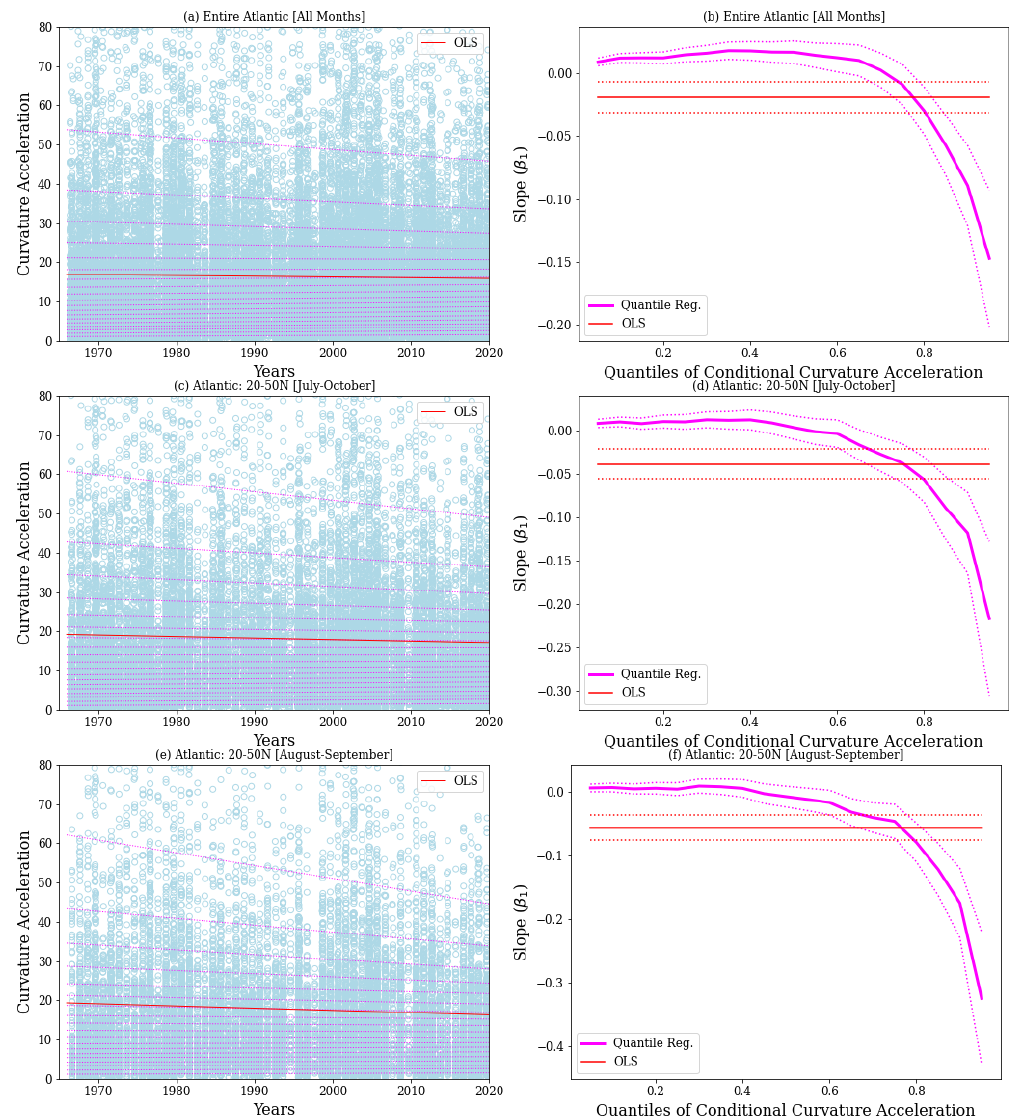
Figure 14. As in Fig. 13 but for curvature acceleration.